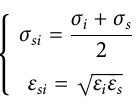
Frontiers in Chemistry |